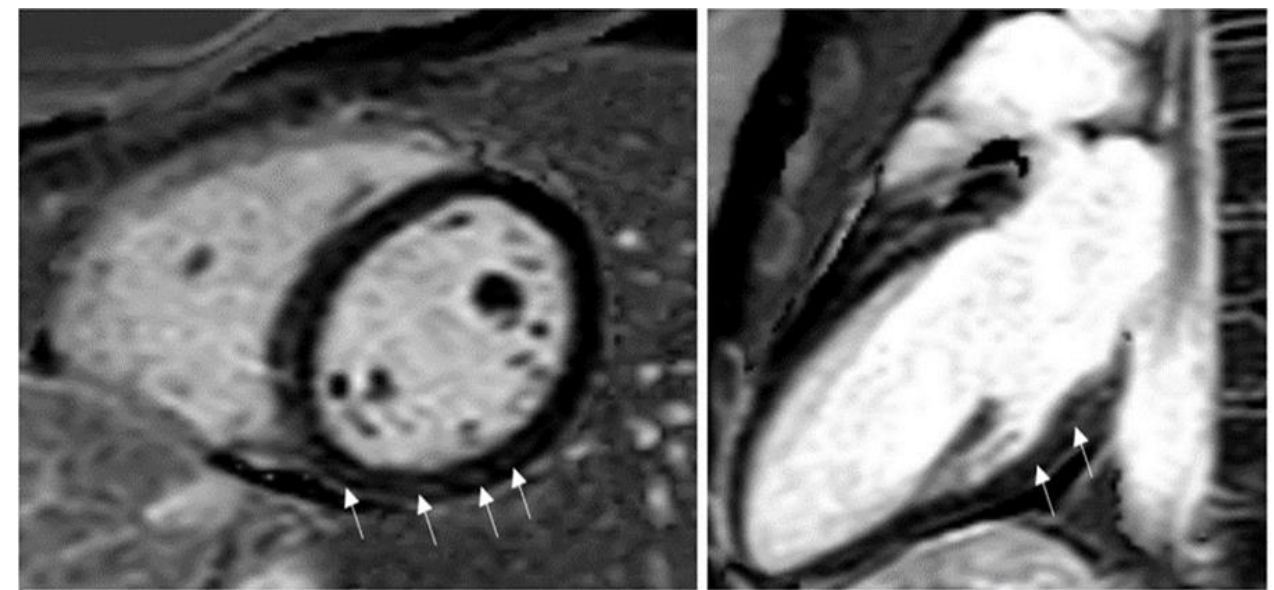
Figure 8. LGE in the mid myocardium of the inferior and lateral wall (white arrows). Clinical vignette: 15-year-old-female soccer player with COVID-19-associated myocarditis. This subject reported shortness of breath and chest pain with activity and was found to have ventricular ectopy and non-sustained runs of ventricular tachycardia on Holter monitoring. Table 2. CMR findings in children and young adults with COVID-19-associated myocarditis.